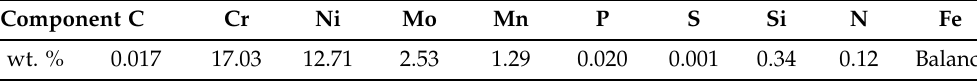
Table 1. Chemical composition of 316LN austenitic stainless steel.